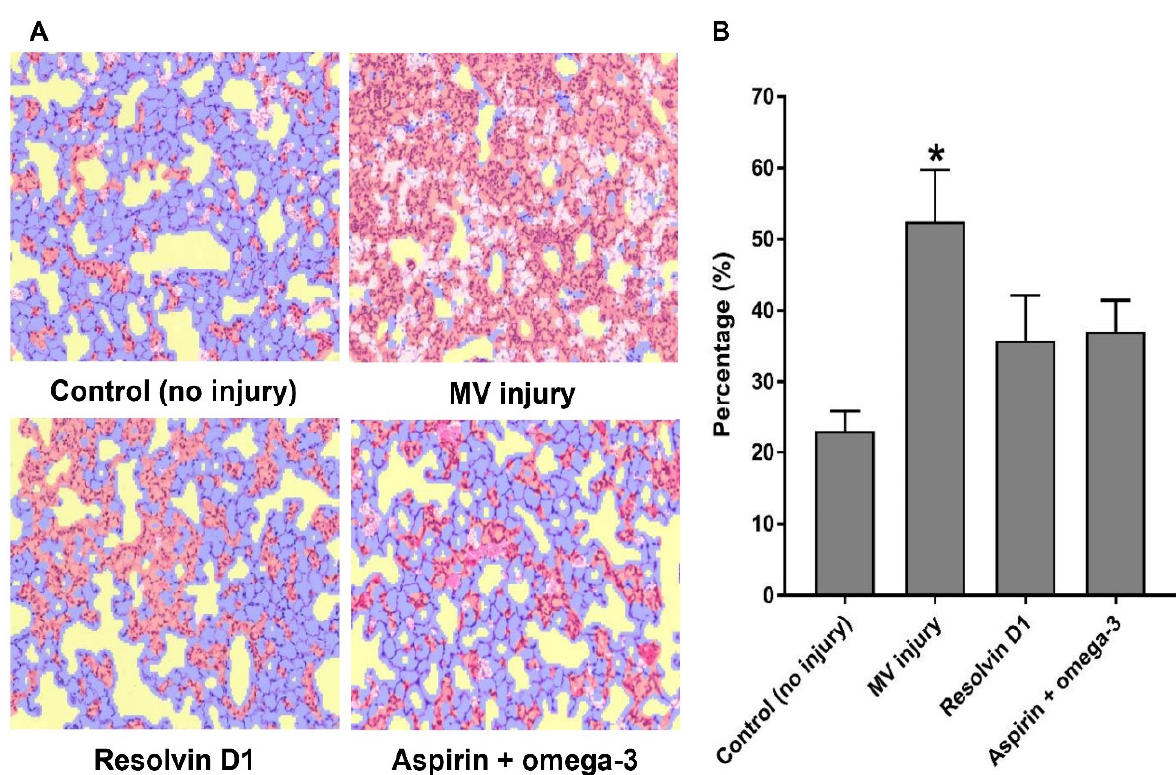
Figure 4. The comparison of proportions of injured regions in lung tissue using automatic detecting software. The total number of mice was 18 (control, 3; only injury, 5; injury after resolvin D1 pretreatment, 4; injury after aspirin and omega-3 fatty acid pretreatment, 4). * p < 0.05 for value vs. control group. ( A ) Automatic detecting areas. The automatically scanned total areas of the region of interest in hematoxylin and eosin-stained lung tissue (red color, injured area; blue color, normal area). ( B ) Mean percentage of injury/total area. MV, mechanical ventilation.